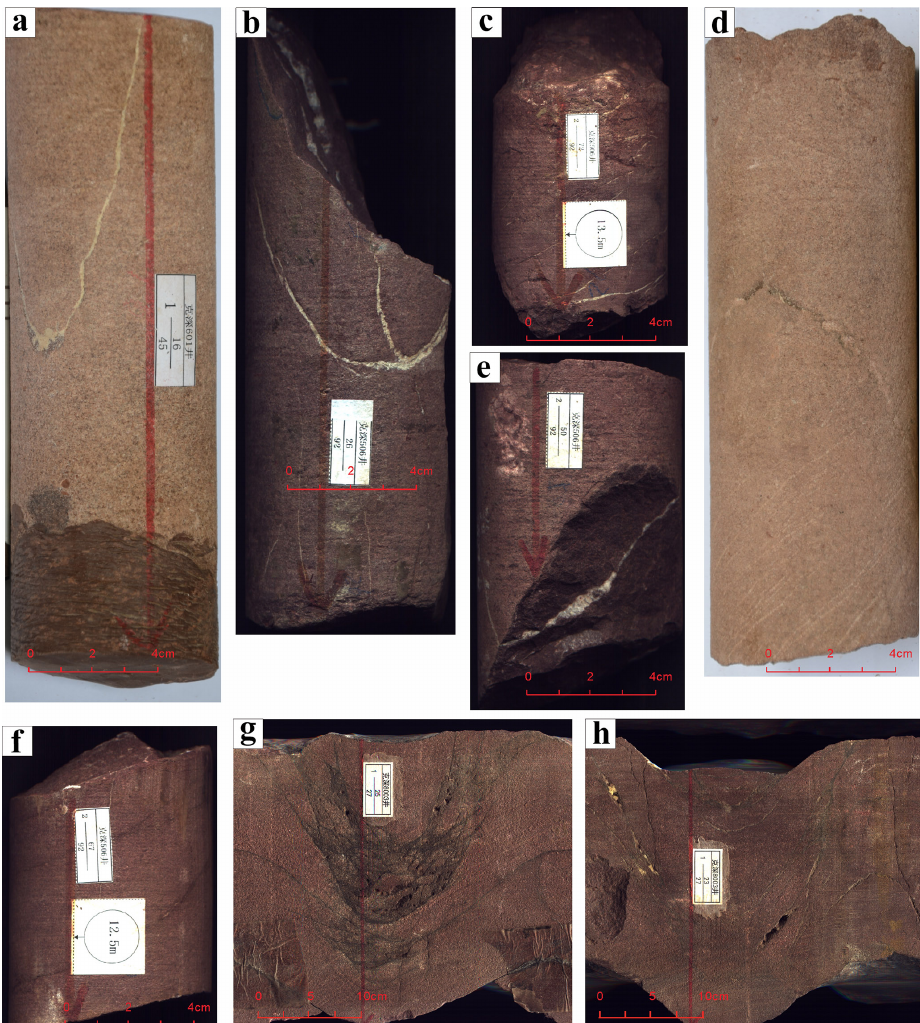
Figure 10. Core photos showing the cementation and dissolution along the fracture surfaces of Cretaceous Bashijiqike Formation in Kuqa Depression. (a) Calcite cemented fracture planes (high angle), Keshen 601. (b) Two calcite veins (high angle), Keshen 506. (c) Horizontal fractures filled by calcite cements, Keshen 506. (d) Dissolution along the fracture plane, enlarged fracture surfaces, Keshen 601,